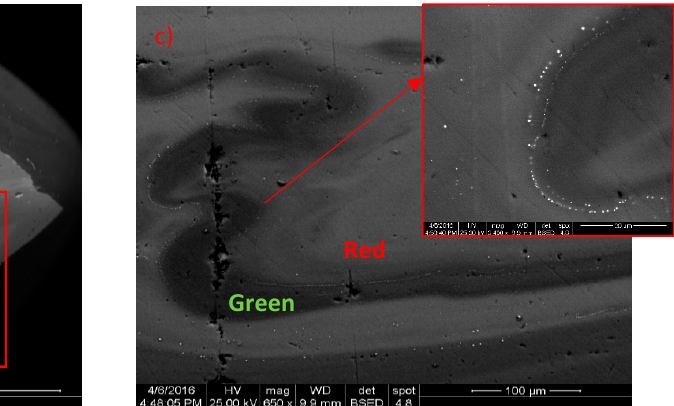
Figure 44. Textural and micro-textural details of a red/green striped glass tessera (sample DMS_13Ngr from the Great Mosque of Damascus, Foy-2 natron glass—unpublished data [24]): ( a ) OM image; ( b ) BSE images showing non-homogenous, zoned vitreous matrix; and ( c ) BSE detail of the area where the green and red glass are juxtaposed. Note the nanometric rounded particles.